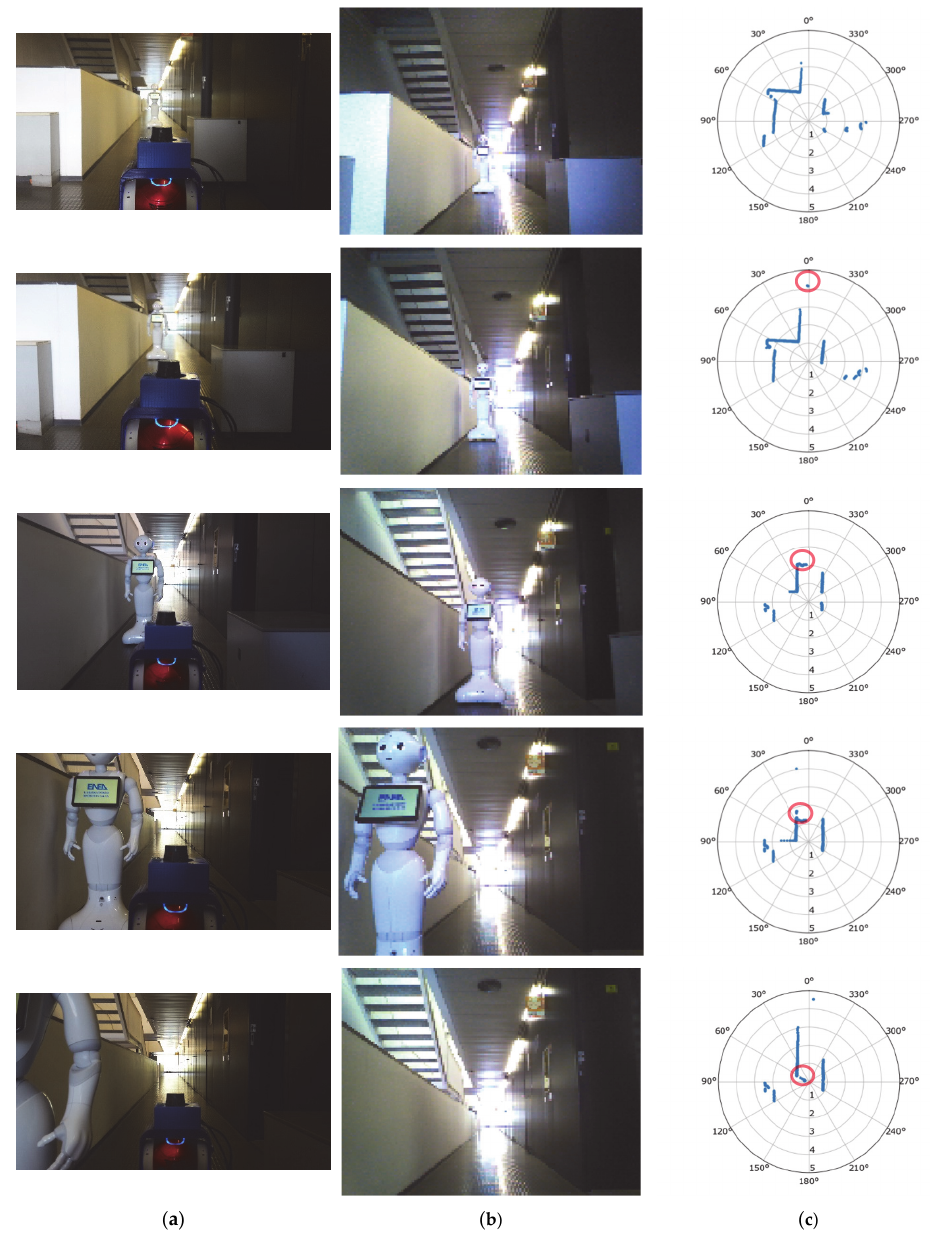
Figure 14. Test #2—scenario #3: ( a ) pictures taken by a camera located behind the NAO, ( b ) pictures taken by the robot’s camera; ( c ) polar diagram from the data acquired by the rangefinder device. The robot is located in the center of the diagram (coordinates 0,0) and oriented toward 0°. Circled in red is the position of the Pepper robot.